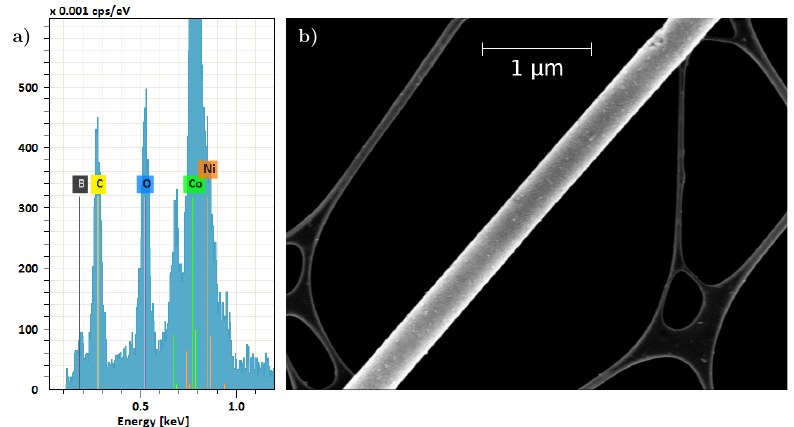
Fig. 7: Chemical analysis using EDX. a) EDX spectra acquired with low primary beam energy (4.5 keV) showing the boron presence aside from expected Co and Ni, as well as C and O coming mainly from the template dissolution and possibly partial tube oxidation for the later element. b) Electron microscopy image of the investigated tube on a lacey carbon film. EDX spectrum taken in the middle of the tube. Similar results were obtained at different points as well as when averaging over larger tube area.